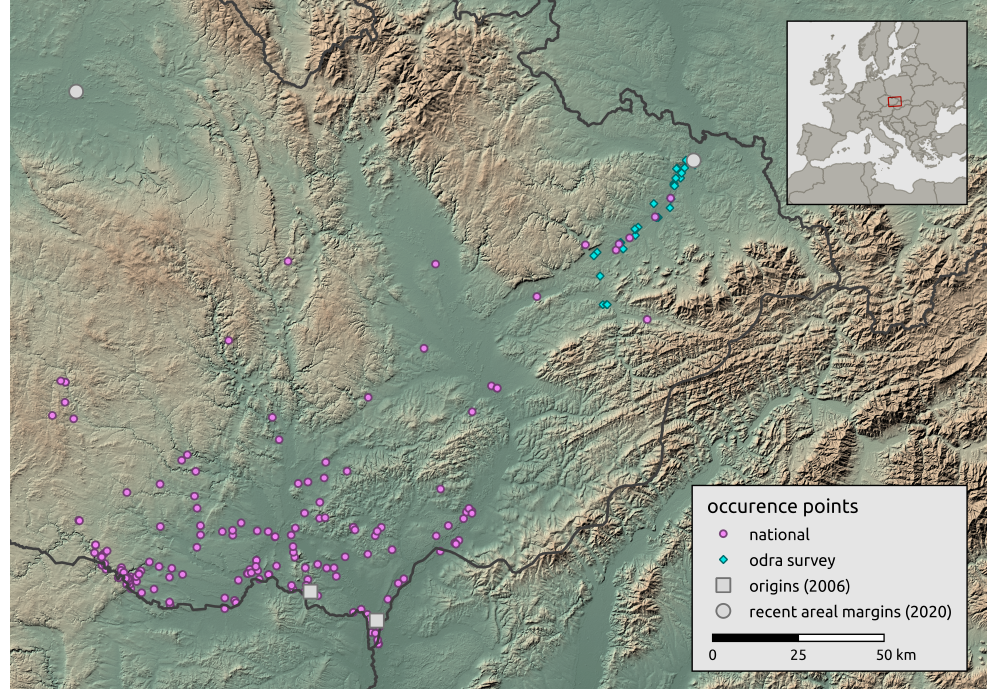
Figure 1. Overview of study area and Ruspolia nitidula occurrences. The occurrences include those in the national (landscape-scale) databases, and those obtained from the regional-scale survey in the Odra River basin.